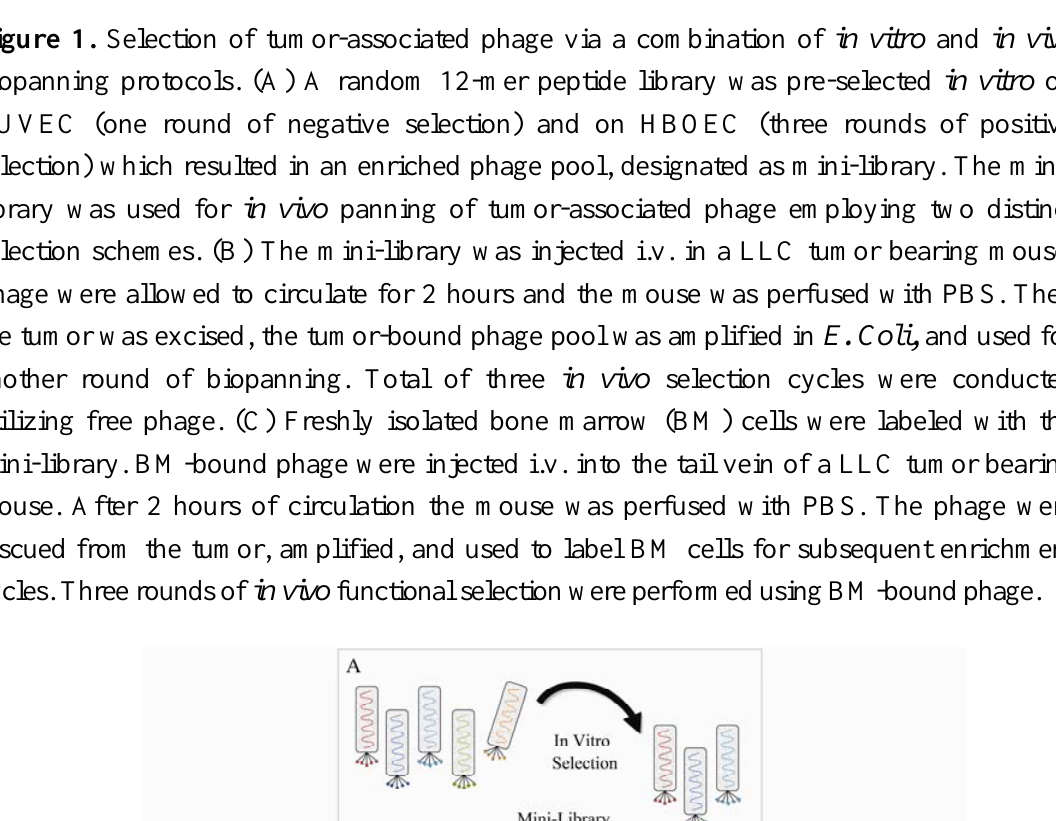
Figure 1. Selection of tumor-associated phage via a combination of in vitro and in